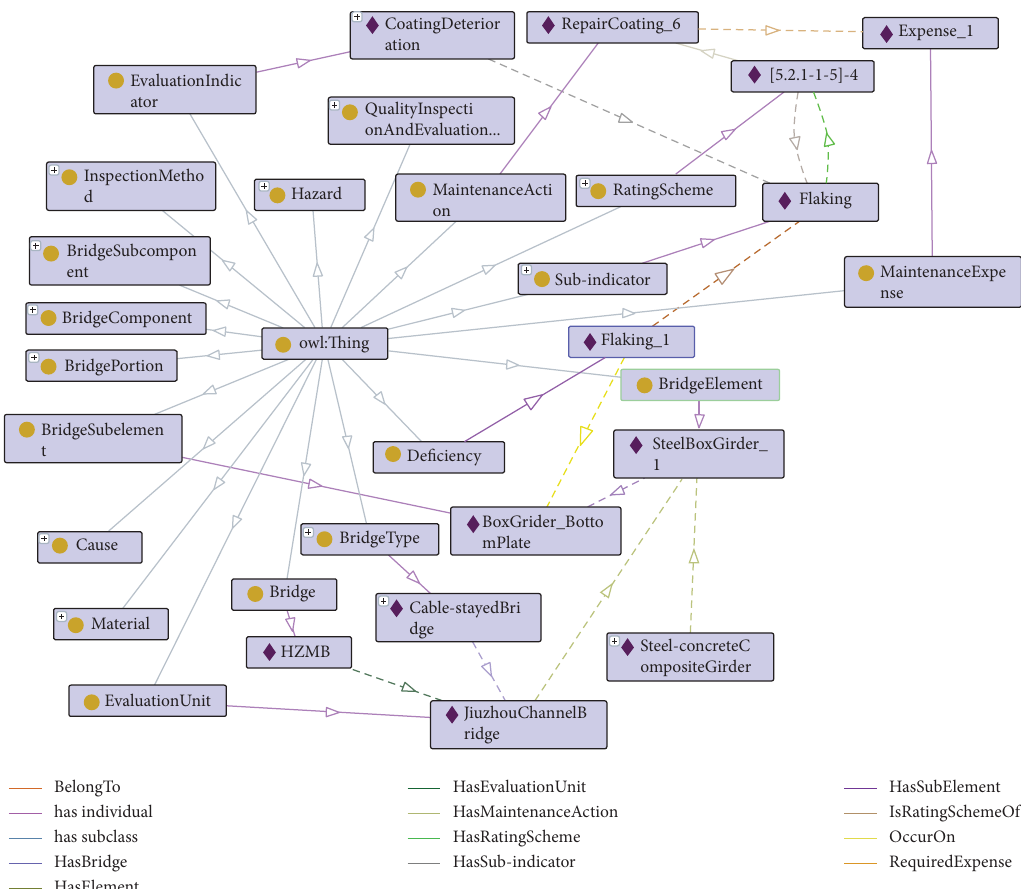
Figure 8: Te BMDO visualization in the Prot´eg´e (partial view).